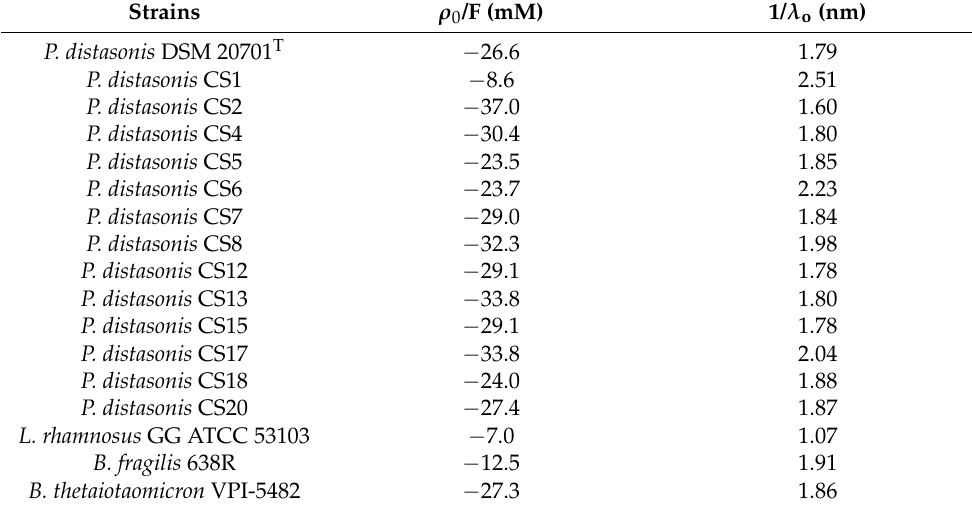
Table 1. Charge density ( ρ o / F , expressed in concentration of equivalents (anionic) charges) and cell surface permeability (1/ λ o ) of P. distasonis and control